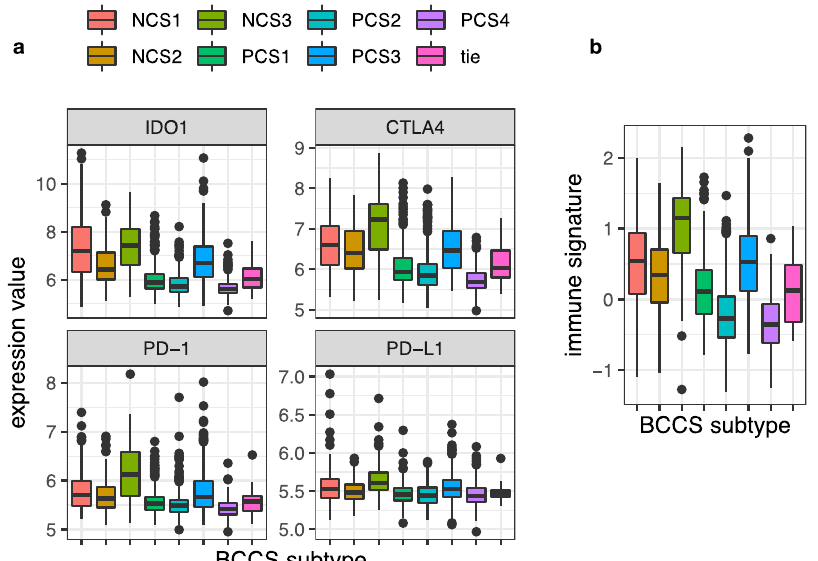
Fig. 4 Distribution by BCCS subtypes for immune regulatory genes, and 18-gene immune signature. a Distributions are plotted by BCCS subtypes of METABRIC for the immune regulatory genes IDO1, CTLA4, PD-1 (PDCD1) and PD-L1 (CD274). b The distributions are plotted by BCCS subtypes of METABRIC of the 18-gene immune signature. Higher values of the score predicted greater sensitivity to pembrolizumab in a previous study. The midline in a boxplot indicates the median, the upper and lower edges indicate the quartiles, and the whisker lines 1.5 times the interquartile